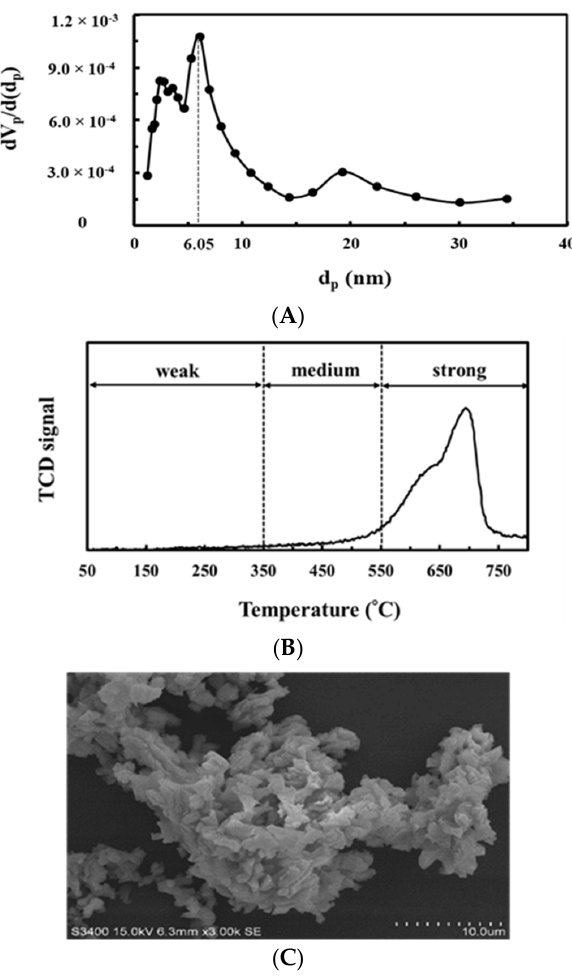
Figure 1. Characterization of CaO derived from eggshells; ( A ) the pore size distribution, ( B ) CO 2 – TPD curve, and ( C ) SEM micrograph.